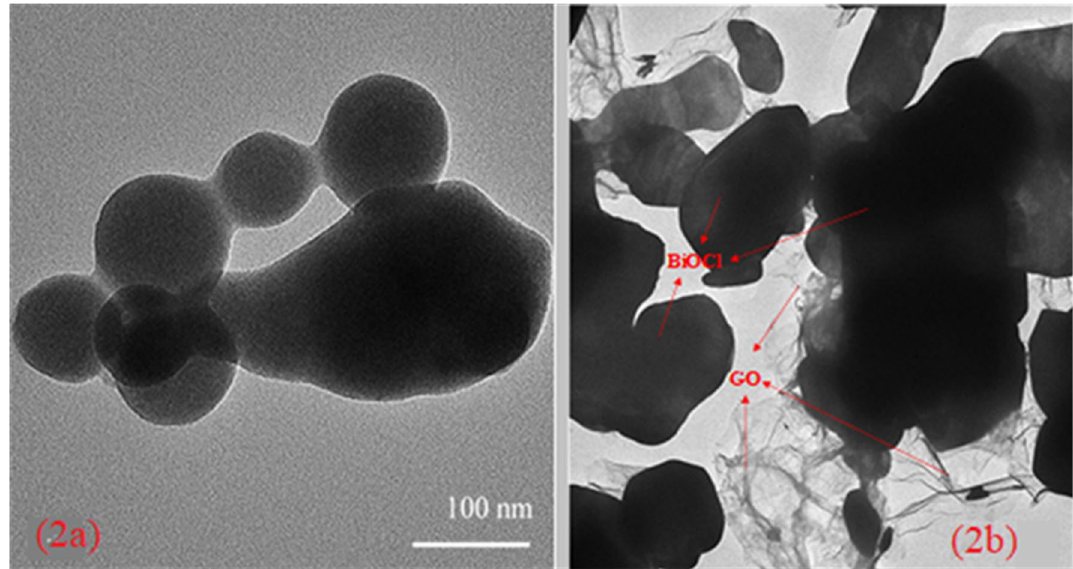
Figure 2. TEM images of ( a ) BiOCl and ( b ) BiOCl–GO